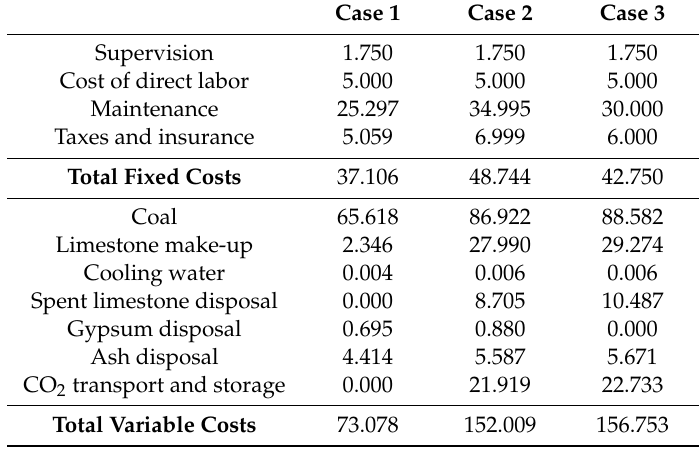
Table 5. Fixed and variable costs in M € / y.